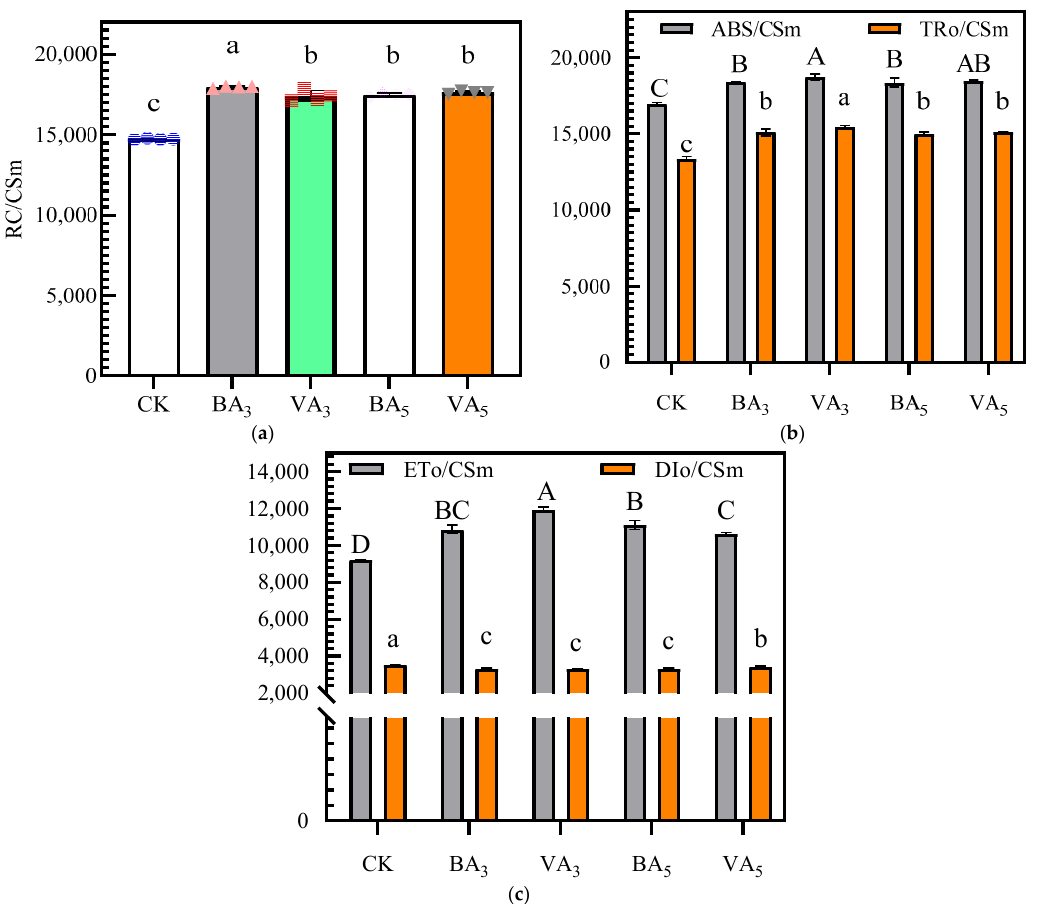
Figure 3. Effect of BA and VA rates on light energy absorption, capture, and transfer: ( a ) Effect of BA and VA rates on the RC/CSm. ( b ) Effect of BA and VA rates on the ABC/CSm and TRo/CSm . ( c ) Effect of BA and VA rates on the ETo/CSm and DIo/CSm . Note: BA represents biochar application and VA vermicompost application. Data are presented as mean ± standard error (n = 4). The meanings of the circles, triangles, and rectangles on the bars in ( a ) are indicated as duplicate data points for the different treatments. Means of RC/CSm , TRo/CSm , and DIo/CSm are significantly different between BA and VA rates ( p ≤ 0.05) when followed by different lowercase letters. Means of ABC/CSm and ETo/CSm are significantly different between BA and VA rates ( p ≤ 0.05) when followed by different uppercase letters. RC/CSm indicates the number of active reaction centers per CS; ABS/CSm indicates the absorption flux per CS; TRo/CSm indicates the trapped energy flux per CS; ETo/CSm indicates the electron transport flux per CS; DIo/CSm indicates the non-photochemical quenching per